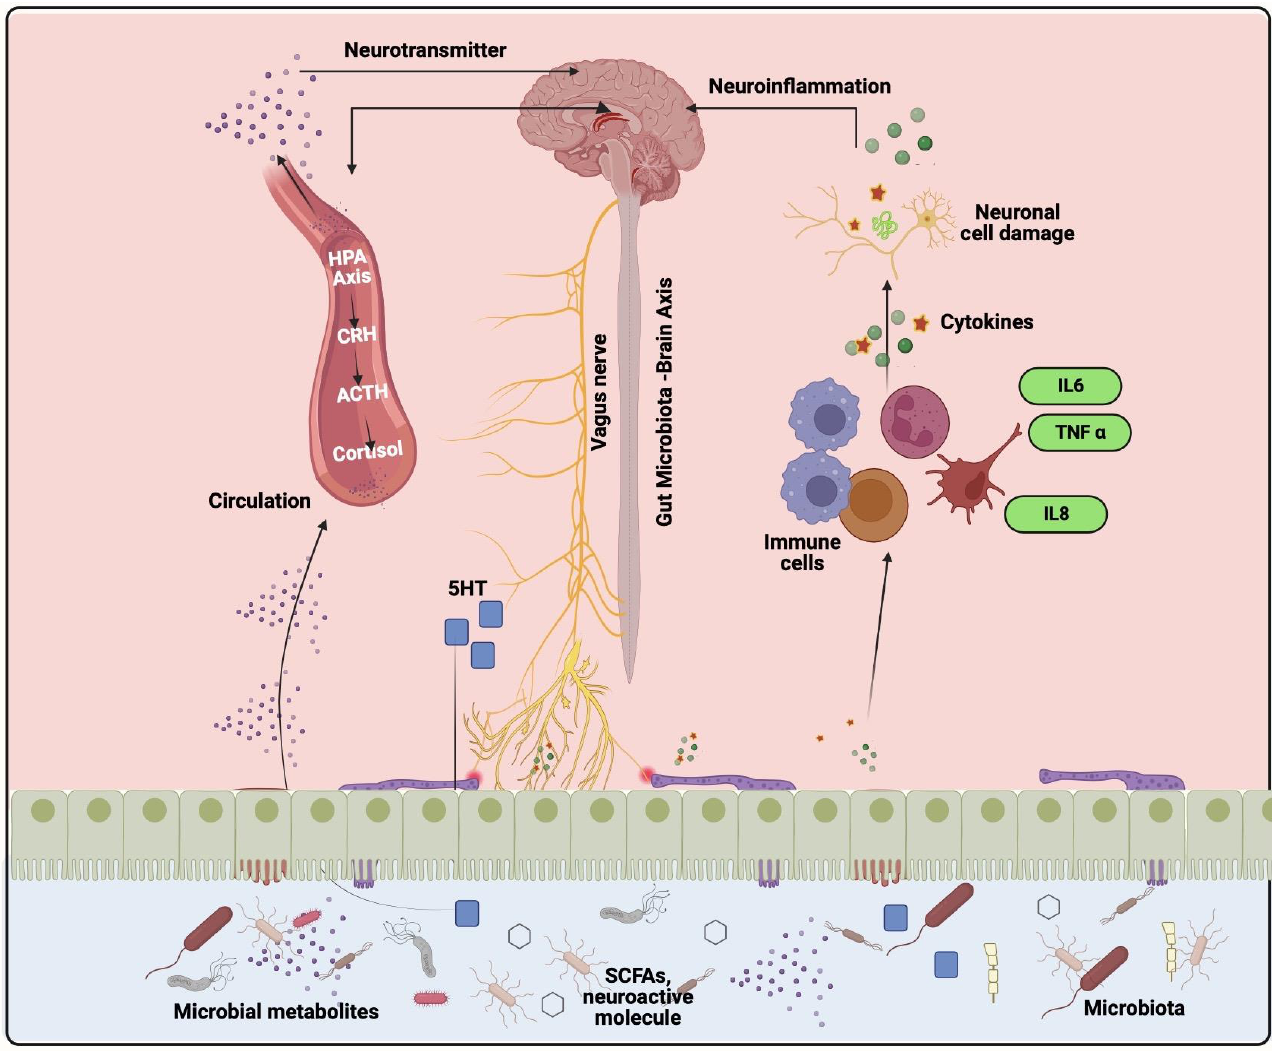
Figure 2. Microbiota–gut–brain axis. Through neural, metabolic, endocrine, and immunological mechanisms, the brain and stomach interact. The vagus nerve, the hypothalamic-pituitary-adrenal (HPA) axis, and systemic circulation are all influenced by the brain’s function on gastrointestinal health. Short-chain fatty acids (SCFAs), neurotransmitters, and amino acids are examples of sig- nals from the stomach that modify brain activity through neuronal cells, the immune system, and hormonal